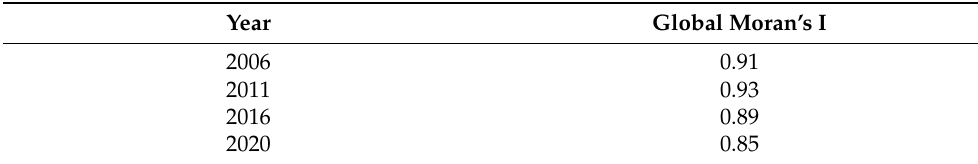
Table 3. Moran’s I values for the four study